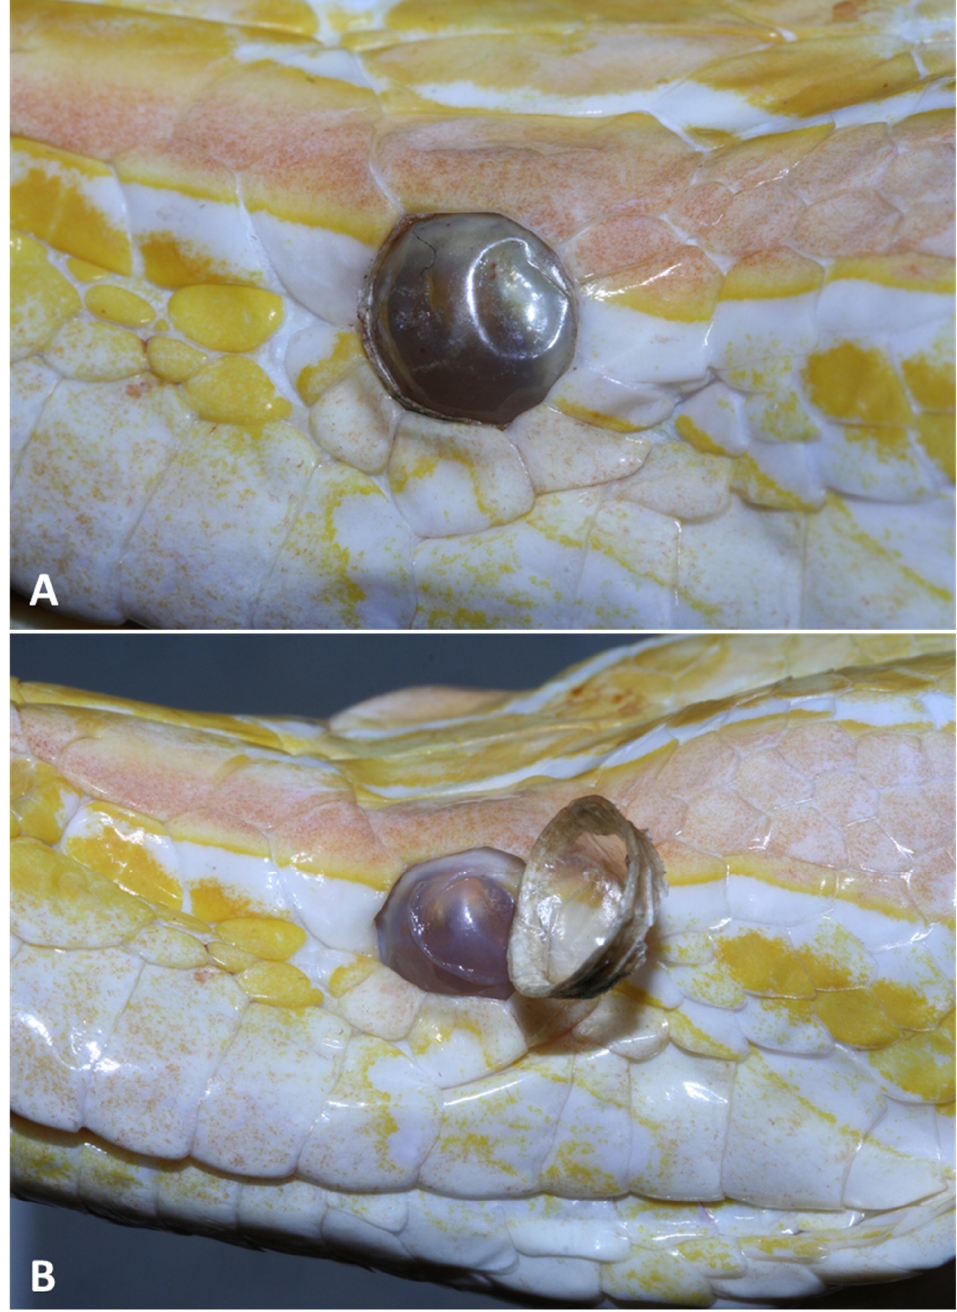
Figure 15. ( A ) Multiple retained layers of the spectacle in a Burmese python ( Python bivittatus ). ( B )